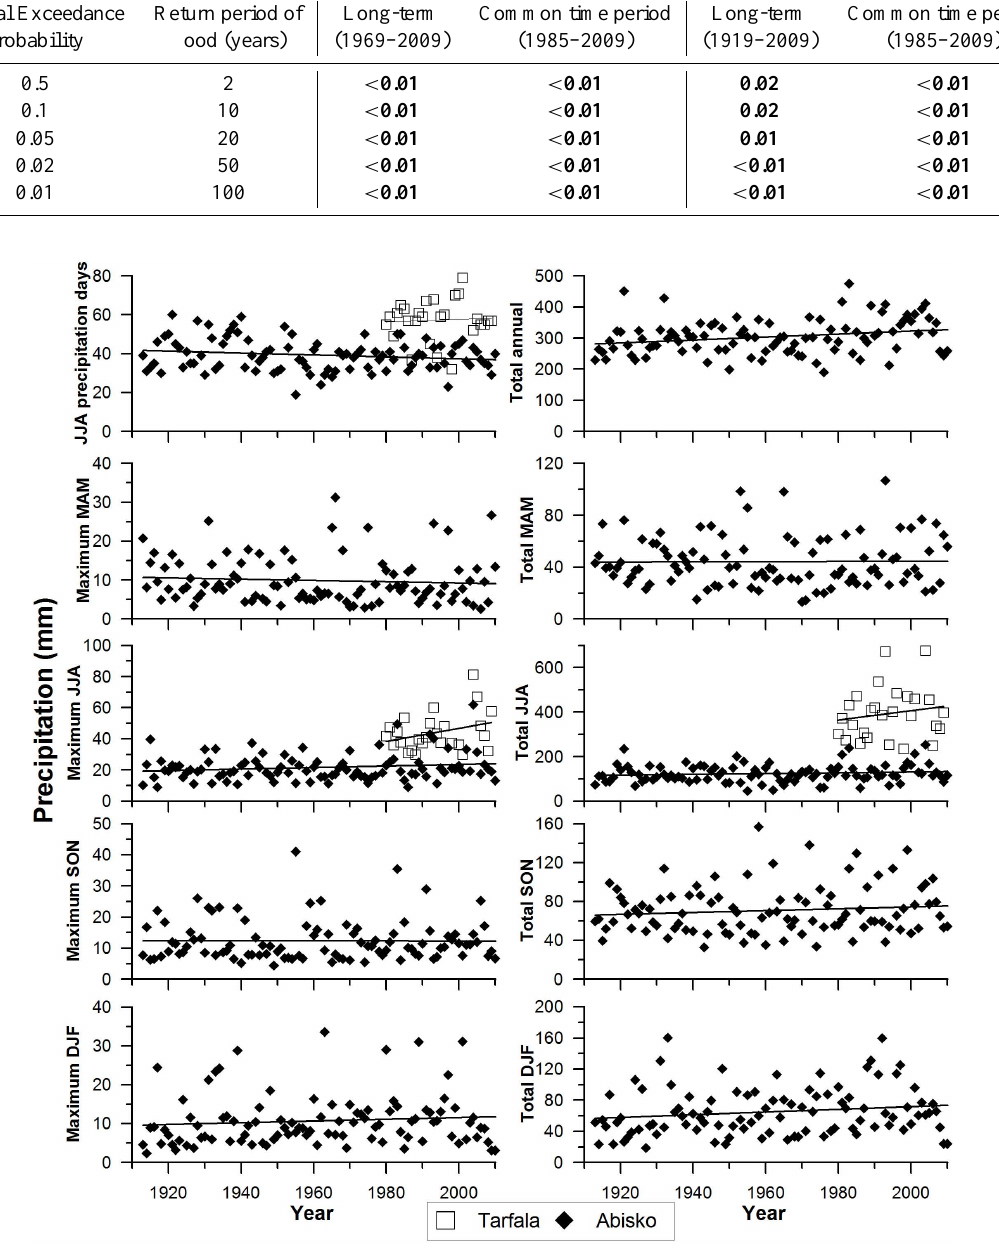
Fig. 3. Time series of annual and seasonal maximum and total precipitation amounts (mm) for the Tarfala (open squares) and Abisko (filled diamonds) catchment. The top left graph shows the number of days with precipitation for the summer (JJA) season. Black lines indicate linear regressions versus time. Linear change rates and MK trend statistics for the long-term record periods and common time windows are presented in Tables 2 and